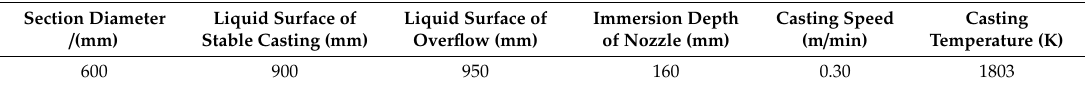
Table 2. Parameters for the mold.